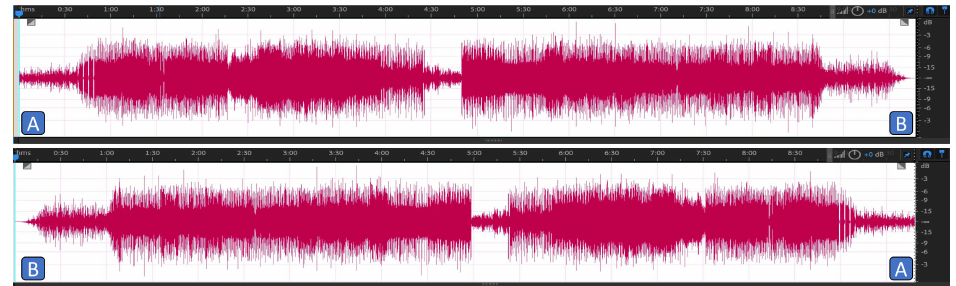
Figure 3. Example of track reversal. The top waveform is presented in the correct direction, where ( A ) is the start of the track and ( B ) is the end. Below, the same track reversed: ( B ) is at the beginning and ( A ) comes last. In this case, if we played the track, the human ear would perceive the sounds